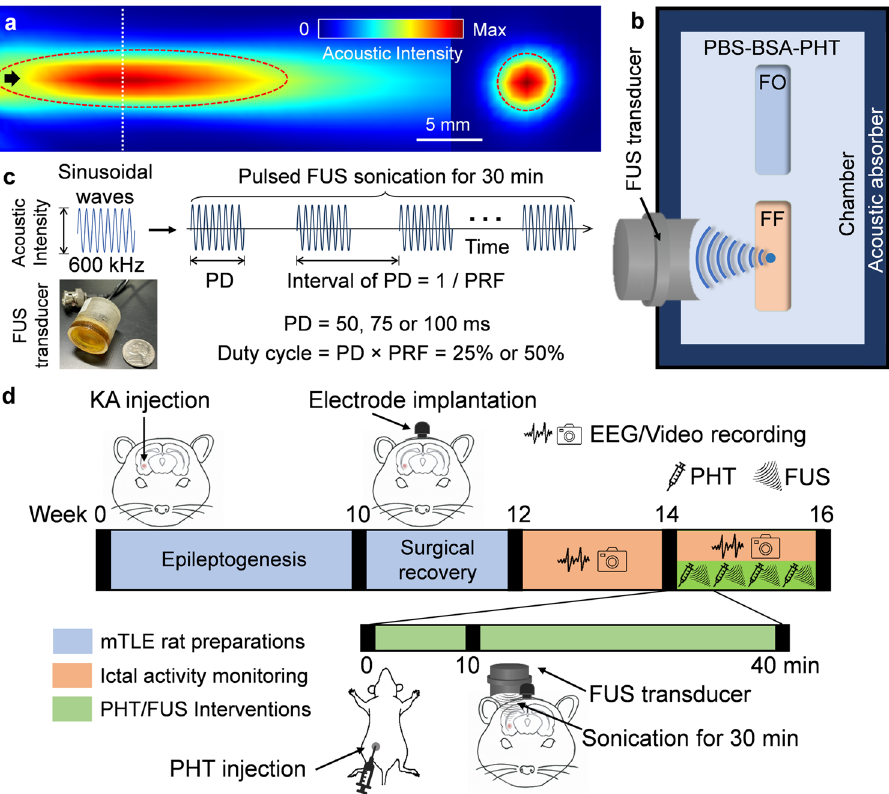
Figure 1. Schematics of the equilibrium dialysis setup and the animal experiments. ( a ) Ultrasound beam profile of the in-house built FUS transducer in acoustic intensity (W/cm 2 ). The intensity map on the longitudinal plane (left) was measured 10 mm away from the exit plane of the transducer while the transverse profile (right) was measured at the acoustic focus (located 20 mm away from the exit plane), indicated as a white dotted line. The FWHM intensity profile is depicted with dotted red lines. The black arrow indicates the direction of sonication. ( b ) Illustration of the equilibrium dialysis settings, depicting the dialysis chamber containing PBS-BSA-PHT cocktail solution, a FUS transducer mounted to the chamber wall, and two submerged dialysis cassettes–one at the acoustic focus (‘FF’), the other outside the path of sonication (‘FO’). Rubber pads at the chamber inner walls were used as acoustic absorber. ( c ) The acoustic parameters used. Inset: the in-house built FUS transducer. ( d ) Diagram of the animal experiments with a timeline of 16 weeks. The mTLE rat models were prepared with intrahippocampal KA injection and electrode head pedestal implantation (weeks 0–12, in blue). EEG ictal activity monitoring sessions with video recording were performed in post-KA weeks 12–16 (in orange). PHT and/or FUS interventions were administered four times in weeks 14–16 (in green), along with EEG/ video recording sessions. The EEG data pair of the 2-week period before (weeks 12–14; pre-intervention) and during (weeks 14–16; post-intervention) the treatments were compared to examine the seizure-suppressive effects. BSA bovine serum albumin, EEG electroencephalogram, FUS focused ultrasound, FWHM full-width at half-maximum, mTLE mesial temporal lobe epilepsy, PBS phosphate-buffered saline, PD pulse duration, PHT phenytoin, PRF pulse repetition